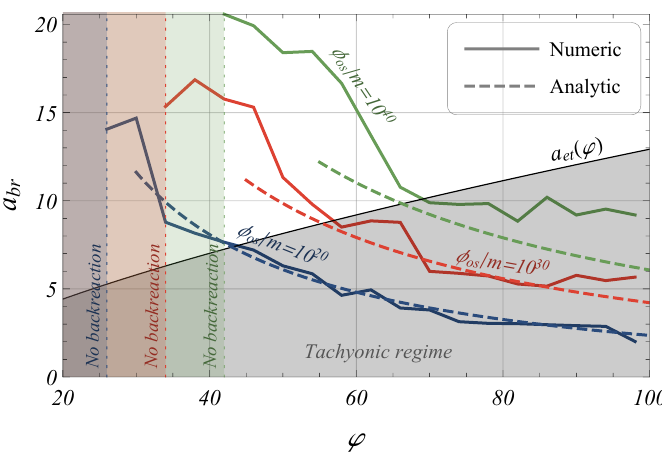
Figure 6 . Estimation of the time ( a br ) when backreaction effects become important for different choices of parameters ϕ and ratio φ os /m = θf a /m . The estimation is based on eq. (2.48). The solid curves are obtained by solving the dark photons equations numerically while the dashed curves are the approximate result of eq. (2.49). Consistent with one’s expectations, for small values of ϕ particle production is not very efficient and backreaction effects are not very important. The black curve shows the end of tachyonic